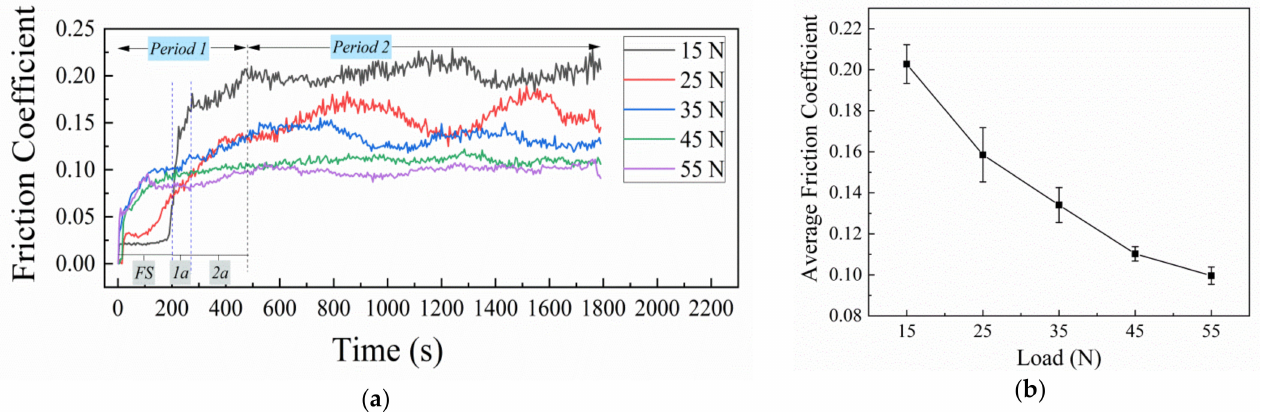
Figure 3. Friction coefficients between the designed copper-iron tribo-pair working under different loads: ( a ) variation of the friction coefficients with wear duration; and ( b ) the average friction coefficients during the stable period.